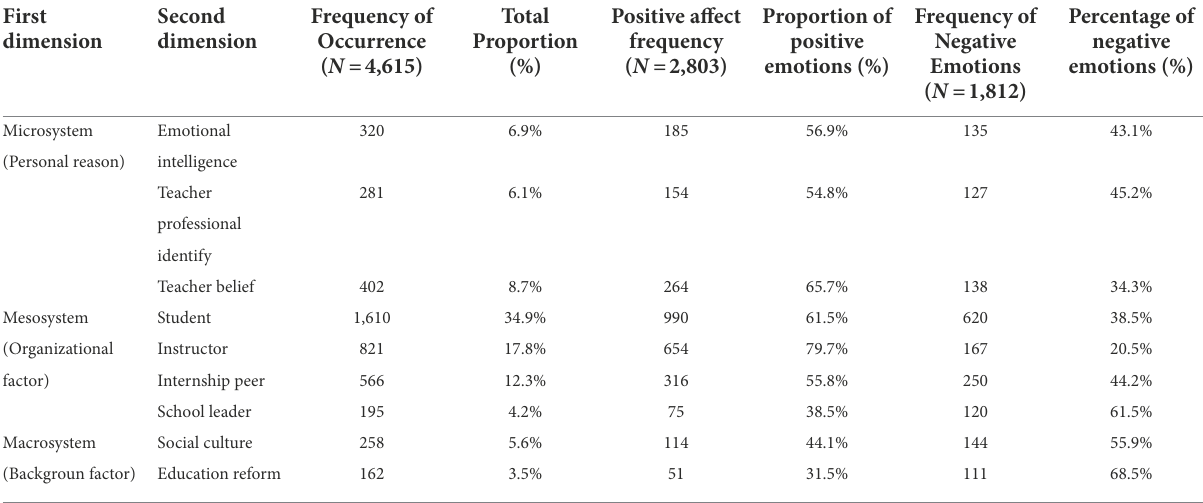
TABLE 5 Sources of the emotional experience of pre-service